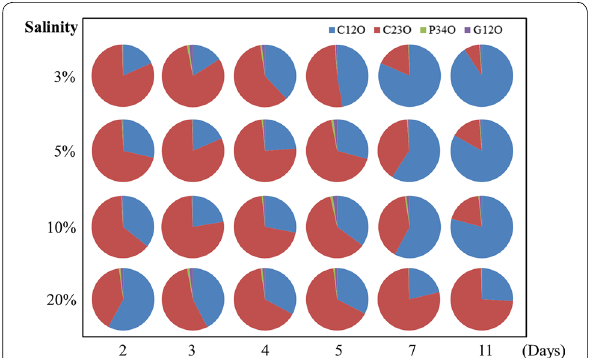
Fig. 5 The ratio of genes encoding C12O, C23O, P34O and G12O in RNA extracted at different time of consortium CY-1 cultured under different